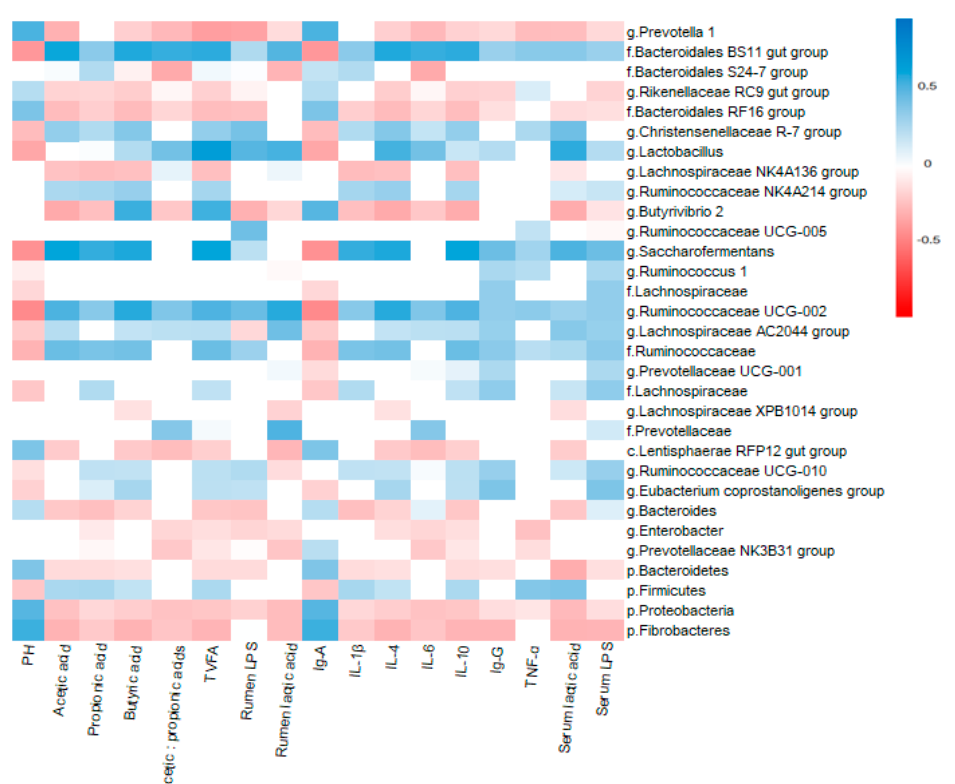
Figure 5. Correlation between rumen microbiota and cattle physiological variables. Spearman non-parametric Rank correlation matrix between serum index, characteristics of rumen fermentation parameters and microbiota abundance (representing at least 1% of the bacterial community in at least one sample). The red color represents a negative correlation; the blue color represents a positive correlation, and the white color represents no correlation. The OTU count data were subjected to variance stabilizing transformation, then pairwise serum index, characteristics of rumen fermentation parameters. Spearman correlations between bacterial and biological parameters at corresponding were analyzed.